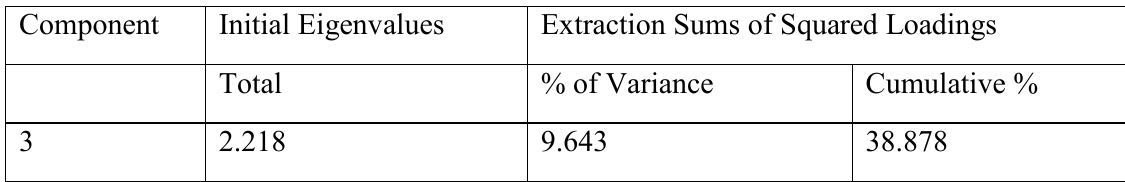
Table 1.27: Variance explained for Adaptive Resilience PC3